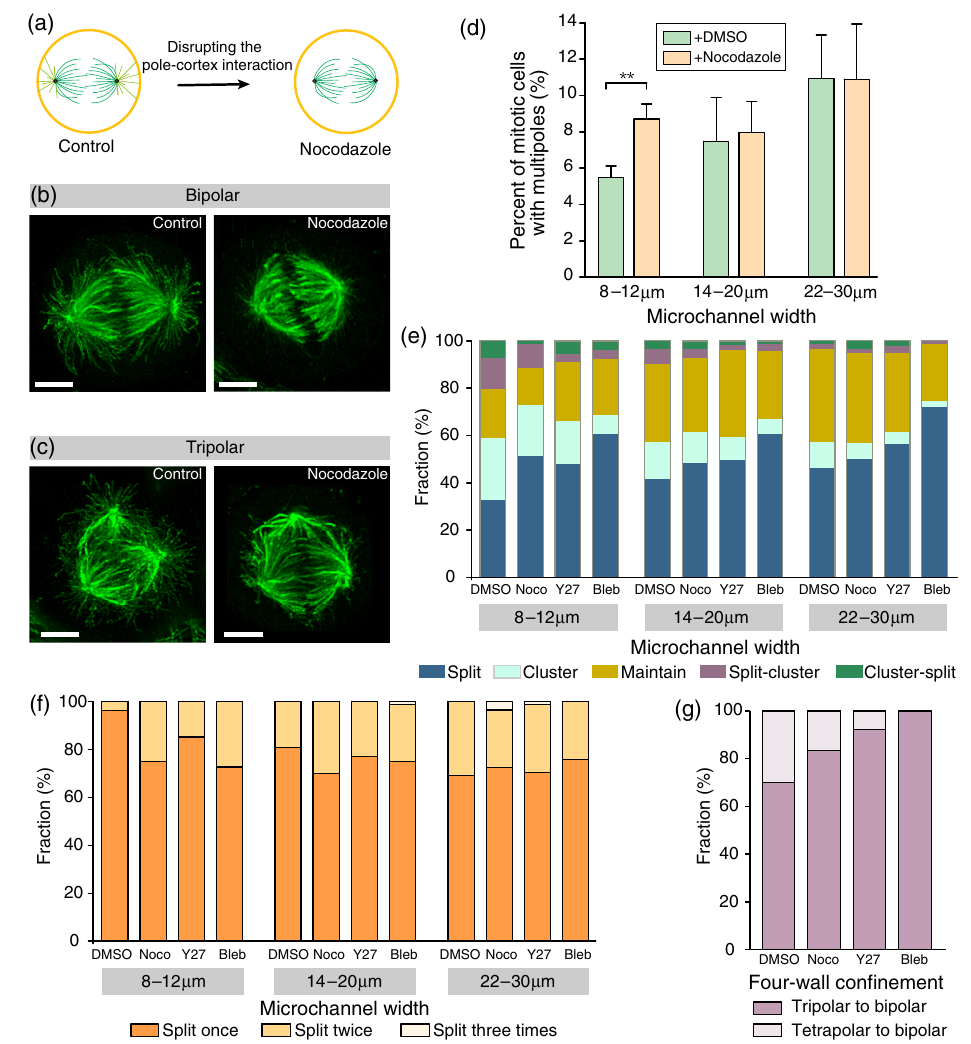
FIG. 6. Disrupting the astral microtubules and confirming the pole-cortex interaction can enhance pole clustering and inhibit pole splitting under four-wall confinement. (a) Schematic diagram showing the disruption of the pole-cortex interaction by low-dose nocodazole treatment (20 nM). (b,c) Bipolar and tripolar spindles in 20-nM nocodazole-treated cells showing the selective disruption of astral microtubules. The scale bar is 5 μ m. (d) Percentage of multipolar spindles in control (DMSO) and nocodazole-treated (Noco) cells under four-wall confinement ( n ¼ 374 , 574, 524, 850, 502, 541). We use a two-sample t-test with (cid:2)(cid:2) p < 0 . 01 . (e) Among all the multipolar spindles, the fraction of pole splitting, clustering, splitting-clustering, clustering-splitting, and maintaining in cells treated with DMSO, 20-nM Noco, 10 - μ m ROCK inhibitor Y27632 (Y27), and 10 - μ m myosin II ATPase inhibitor blebbistatin (Bleb) under four-wall confinement [ n ¼ ð 83 ; 70 ; 148 ; 51 Þ ; (122, 83, 348, 139); (84, 58, 151, 75)]. (f) The fraction of cells with one or more pole splittings in DMSO and Noco/Y27/Bleb-treated cells under four-wall confinement [ n ¼ ð 27 ; 36 ; 61 ; 33 Þ ; (52, 40, 170, 84); (39, 29, 85, 54)]. (g) Comparison of pole clustering from tripolar or tetrapolar spindle to bipolar spindle in DMSO and Noco/Y27/Bleb-treated cells under four-wall confinement ( n ¼ 30 , 12, 39,